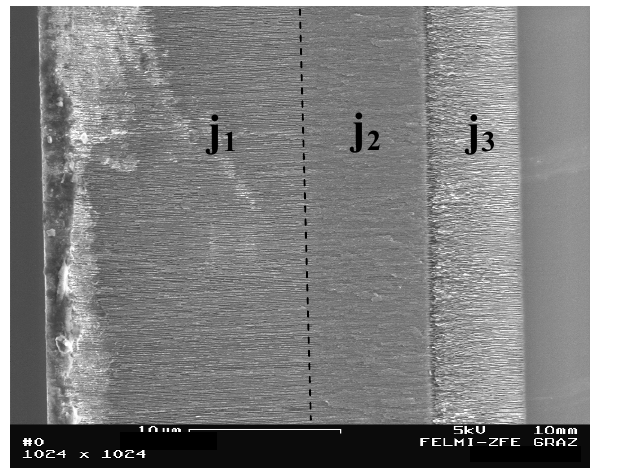
Figure 12. Left: Transition region between three porous silicon layers of different porosities, etched with three changing current densities (j j = 125 mA/cm 2 ) . In the right micrograph the zoomed-in boundary between the two layers 3 etched with j and j which is quite sharp, is shown. The uncertainty concerning the 2 3 roughness of the transition lies far below 100